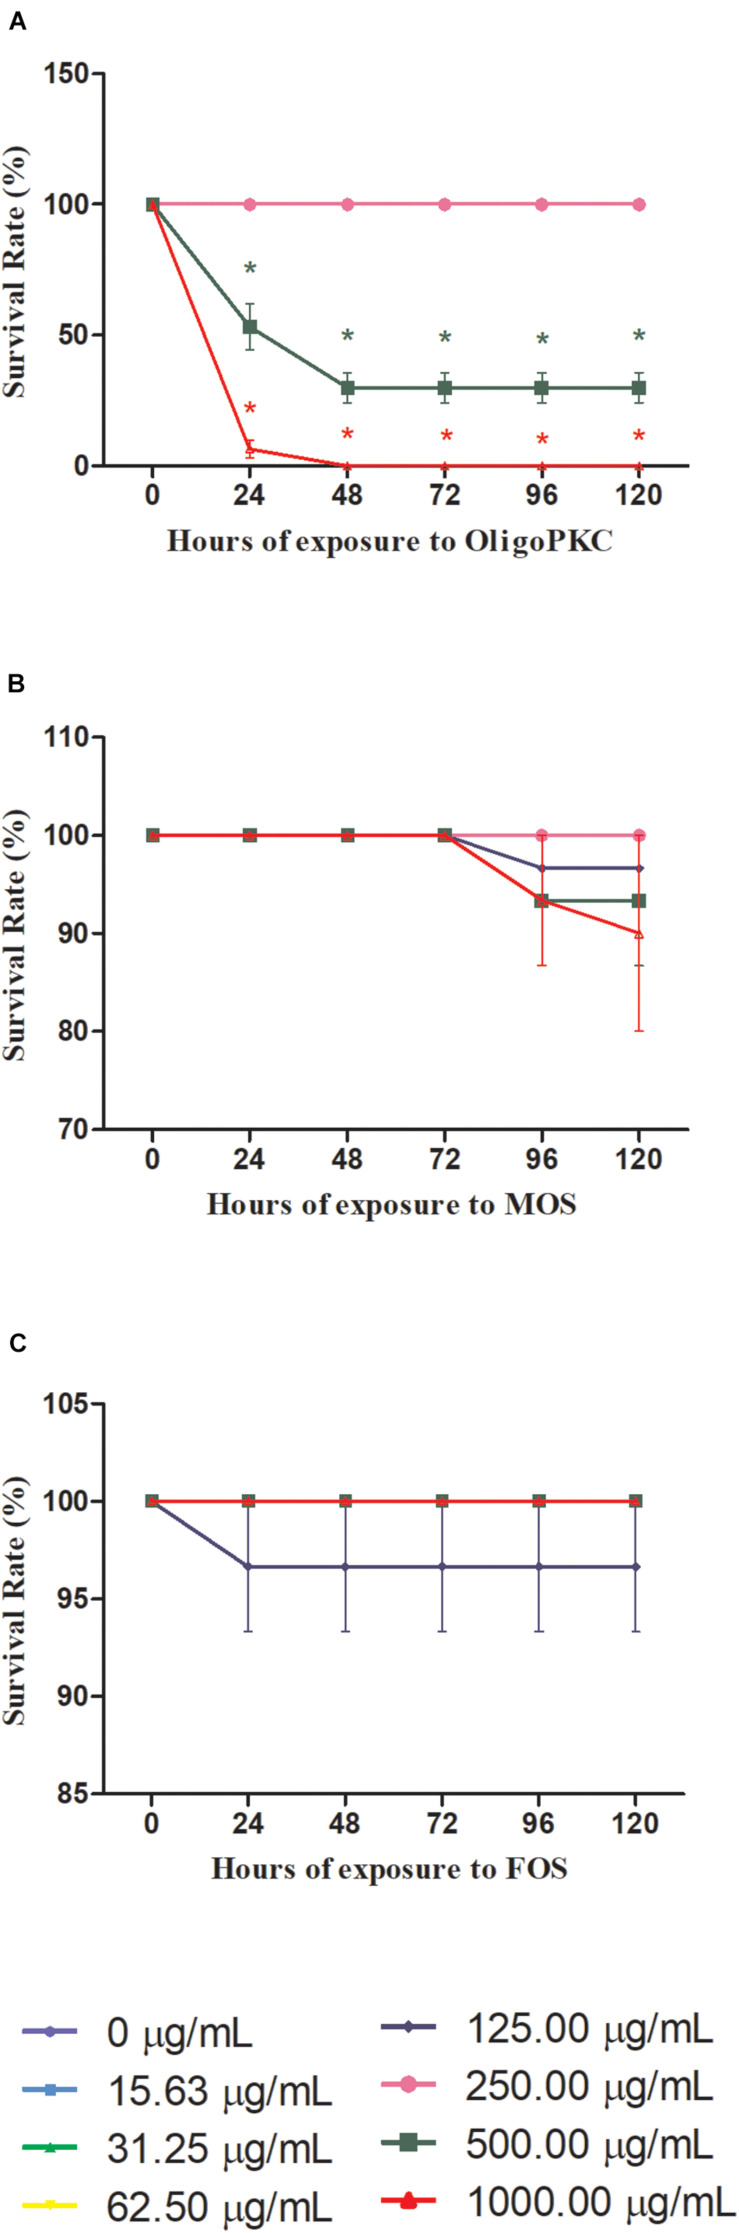
Survival rates of zebrafish embryos treated with different concentrations of (A) OligoPKC; (B) MOS; and (C) FOS. Each plotted value represent the mean ± SEM of three biological replicates with each biological replicate containing (n = 10) fishes. Statistical analysis was done using Kruskal-Wallis test followed by Dunn’s Multiple Comparison Test. Means with the symbol “*” are considered significantly different (p ≤ 0.05) compared to the untreated control. Data points appear overlapped at 100% survival rate.